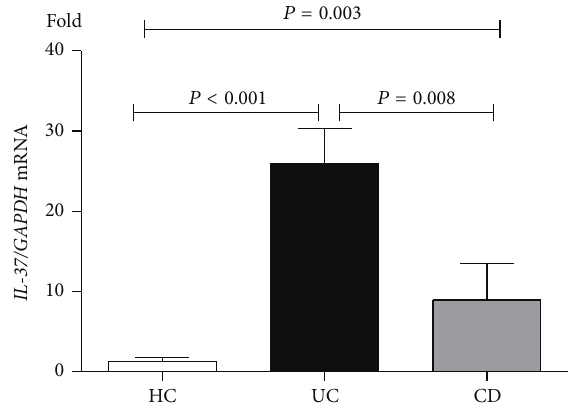
Figure 6: IL-37 gene expression in colonic mucosa from IBD patients. A significant increase in IL-37 mRNA was shown in inflamed mucosa of patients as compared to controls.